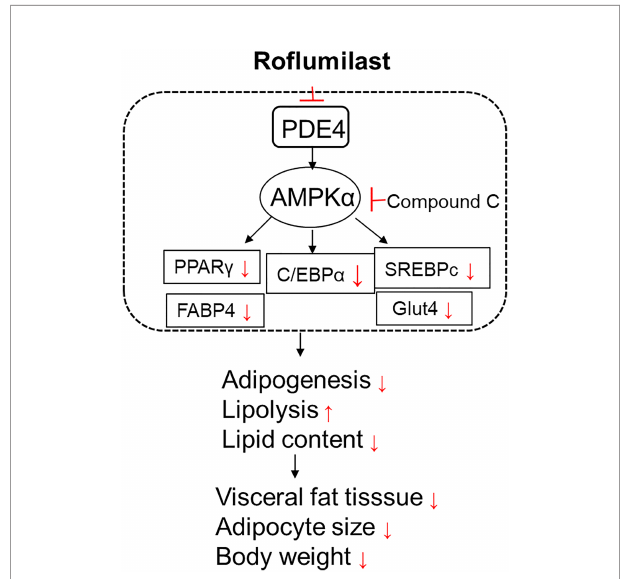
FIGURE 8 | A graphic presentation of the underlying molecular